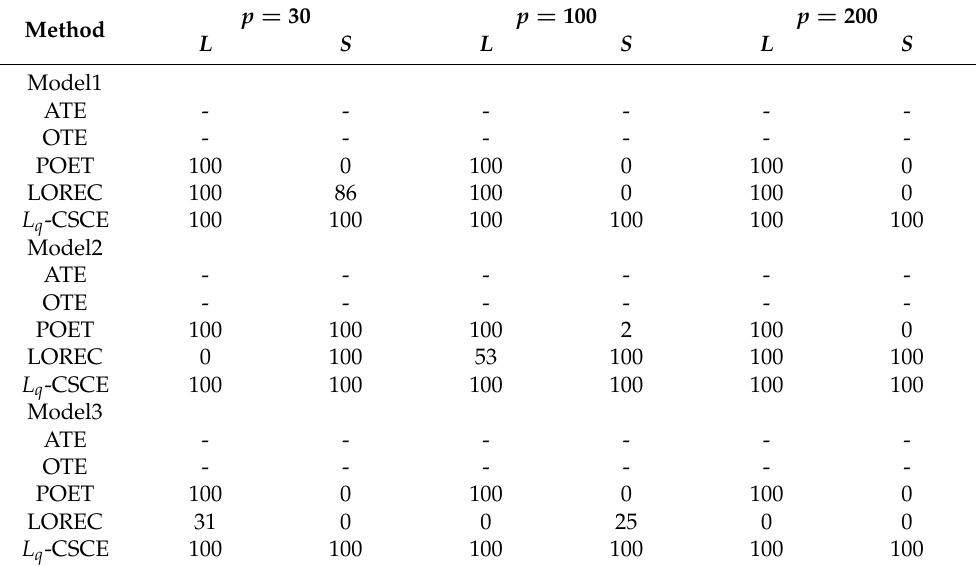
Table 4. Record of the number of positive semi-definite matrices over 100